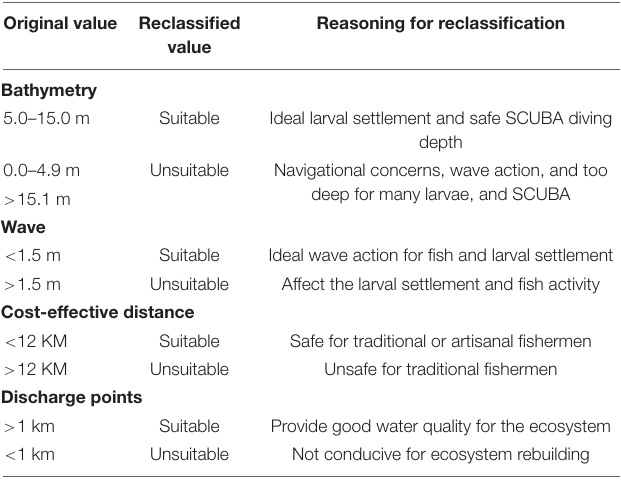
TABLE 1 | Reclassification values for bathymetry, wave height, cost-effective distance, and discharge points data used in the exclusion mapping model (adapted and modified from Barber et al., 2009).